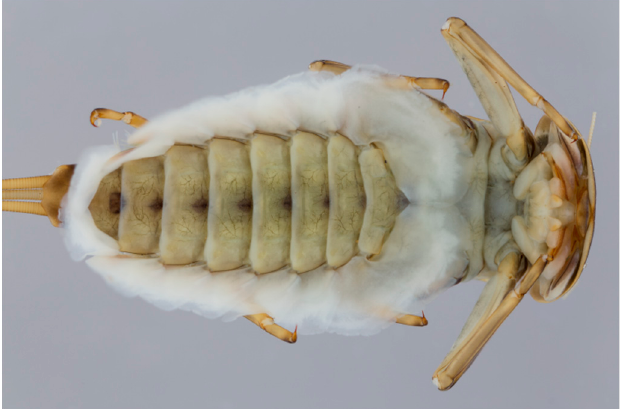
Figure 4. Rhithrogena loyolaea Navás (Heptageniidae, Switzerland) in ventral view to show the gills adapted to function as a suction disk.